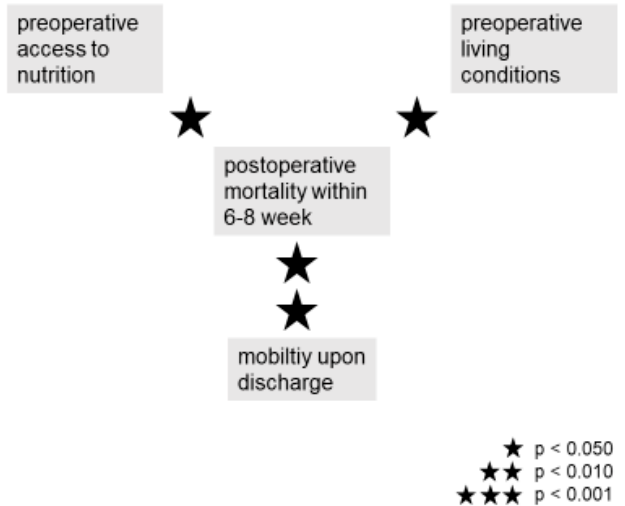
Figure 6. Correlation between clinical parameters and the postoperative mortality within 6–8 weeks.